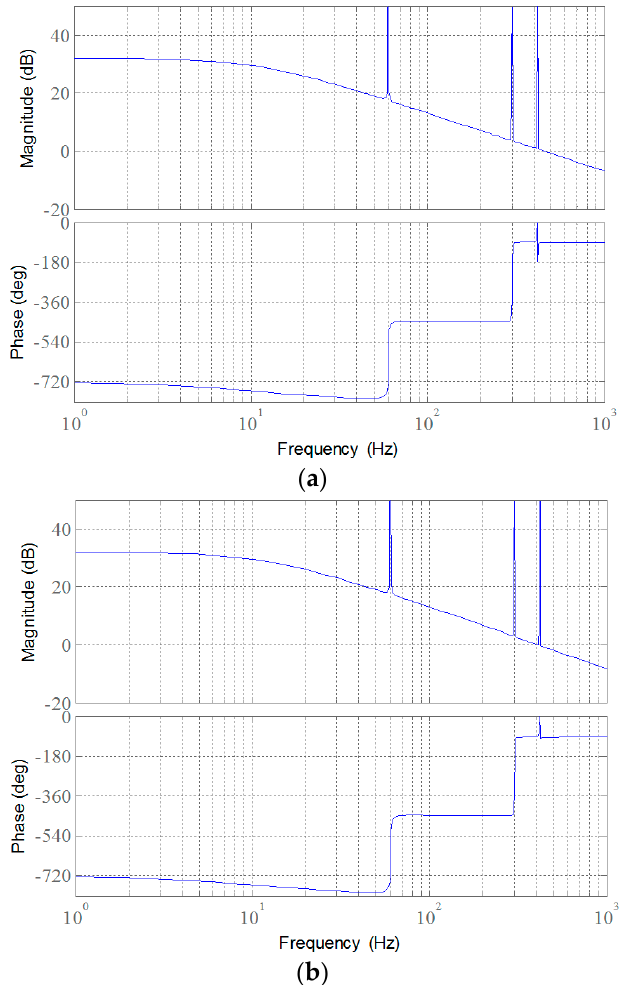
Figure 13. Frequency responses for the open-loop transfer function under inductance variation. ( a ) nominal value of inductance; and ( b ) +20% variation.